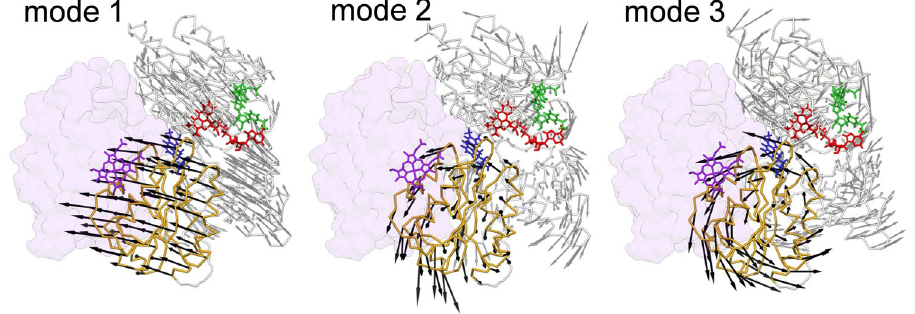
Figure 5. Principal modes of CPR obtained by the principal component analysis for the thermal fluctuation in the reduced state. Three largest-amplitude principal modes (mode 1, 2 and 3) are shown. Each principal mode is represented by a set of vectors (arrows). To highlight the movement of the FMN domain (black arrows), the principal modes are depicted after superimposing the FAD domain onto the CPR-HO complex